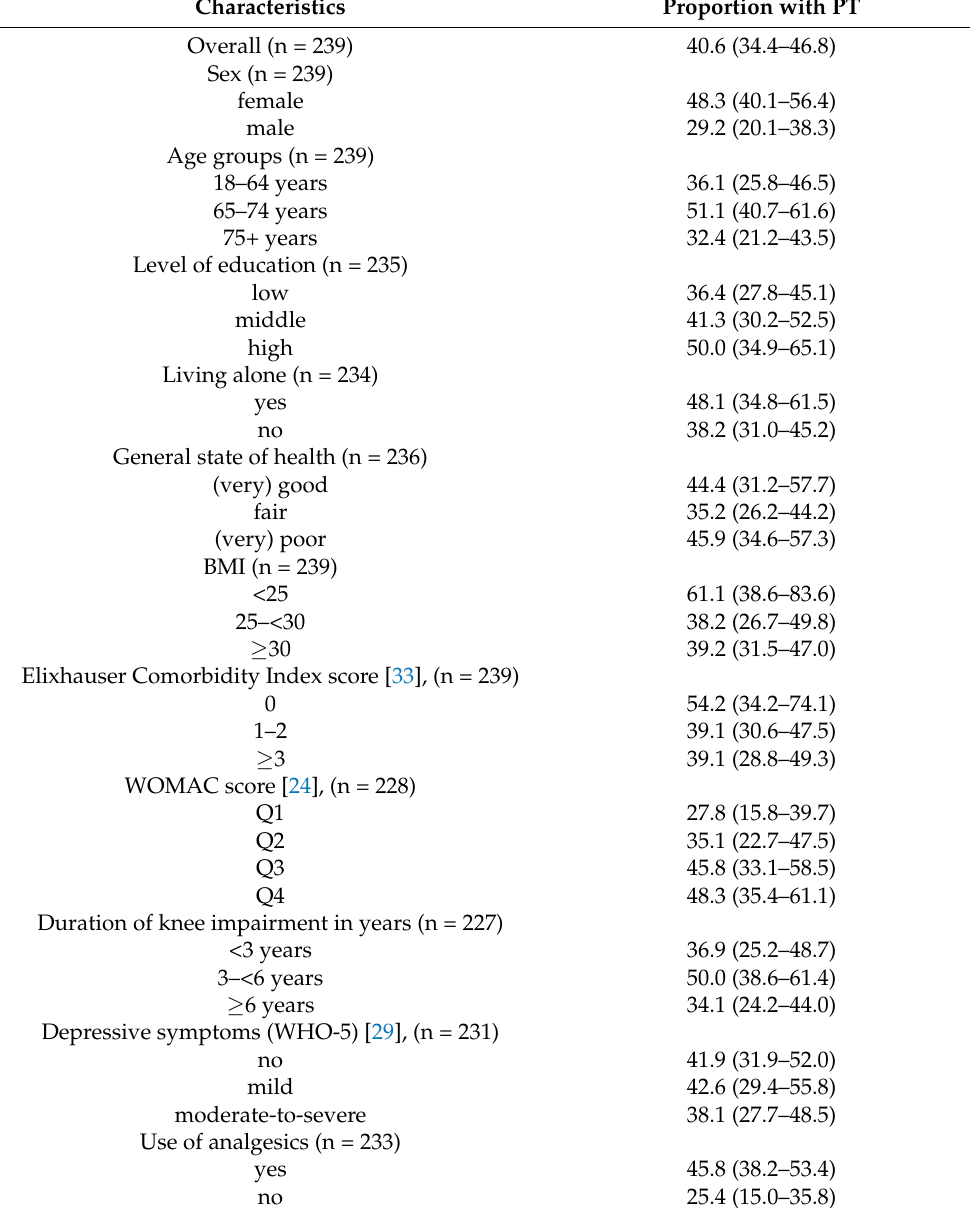
Table 2. Utilization of physiotherapy (PT) in % with 95% confidence limits (CI), depending on covariates.